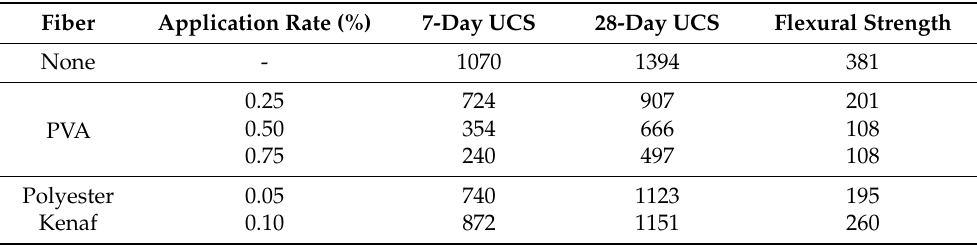
Table 1. Comparison of the strength tests for CSEB containing different fiber